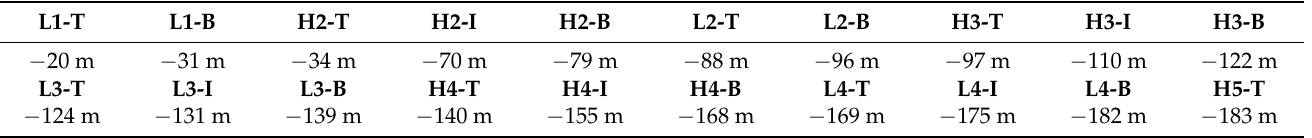
Table 3. Observation points of the model (nomenclature and depths) located at a distance of 217 m from the shoreline.